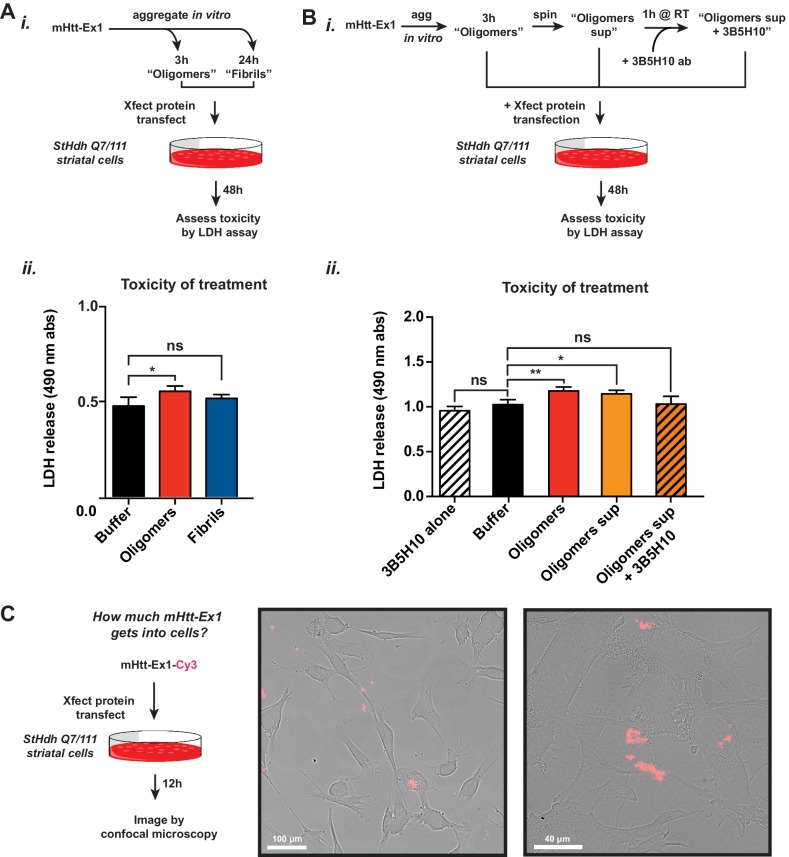
Exogenous addition of mHtt-Ex1 oligomers and aggregates to striatal cellsA. i. Experimental schematic of generating mHtt-Ex1 oligomers and aggregates in vitro and their exogenous addition to StHdhQ7/111 knock-in striatal cells. mHtt-Ex1 species were added to cells using protein transfection (Xfect kit, Clontech). Toxicity was assessed via LDH assay (Promega) 48h after their addition. ii. Measurement of LDH release as a proxy for cell death. Buffer control was the original sample buffer for the mHtt-Ex1 in vitro species. Data are mean ± SD. *p < 0.05. B. i.Experimental schematic. Experimental set-up was similar to (A) with the addition of a spin to procure just the soluble supernatant of the aggregation reaction after 3h. The supernatant was also pre-incubated with the 3B5H10 polyQ conformational antibody for 1h at RT to allow binding between any soluble oligomeric species and the 3B5H10 antibody. ii. Measurement of LDH release as a proxy for cell death. Data are mean ± SD. *p < 0.05, **p < 0.01 C.Left: Experimental schematic. mHtt-Ex1 was labeled with fluorescent Cy3-maleimide dye, then added to StHdh- Q7/111 striatal cells using the Xfect protein transfection kit, similar to (A) and (B). After 12h, cells were fixed and imaged via confocal microscopy (Right) to determine proportion of mHtt-Ex1 that gets into cells.